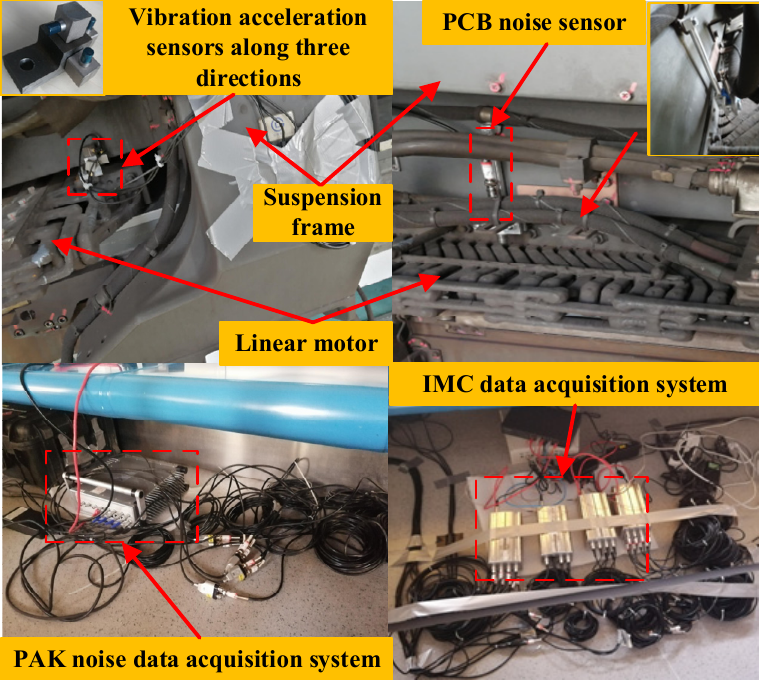
Figure 2. Field installation layout of data acquisition systems and sensors.